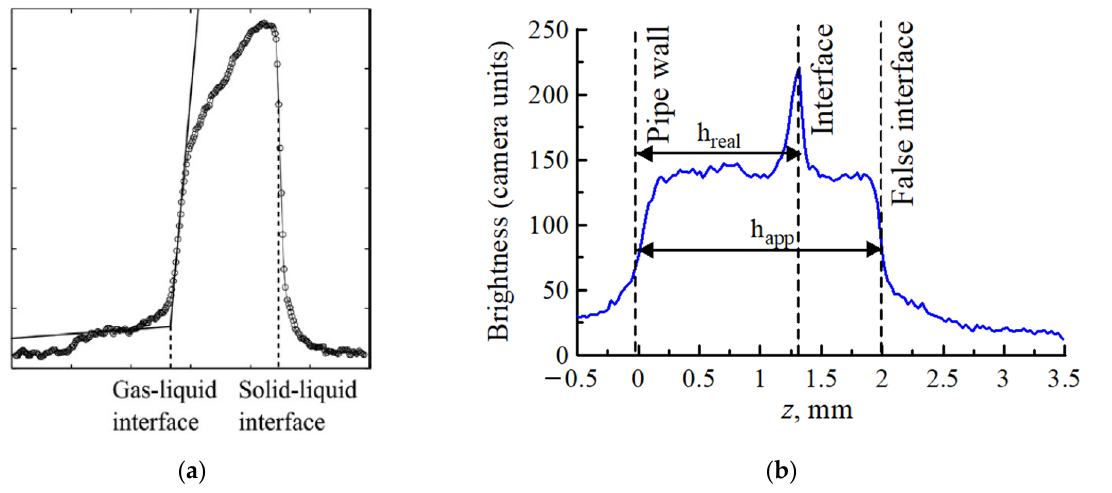
Figure 2. Brightness of raw PLIF signal along the coordinate normal to the wall. ( a ) Falling film on a plate, 𝜃 = 35° [54]; ( b ) Annular gas-sheared film in a pipe, 𝜃 = 70° [68].